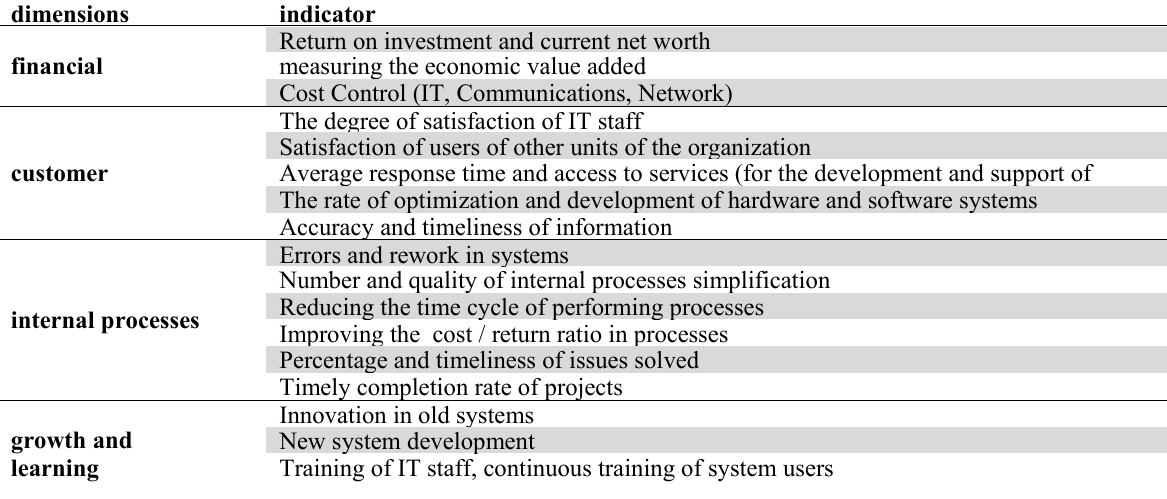
Information technology indicators in